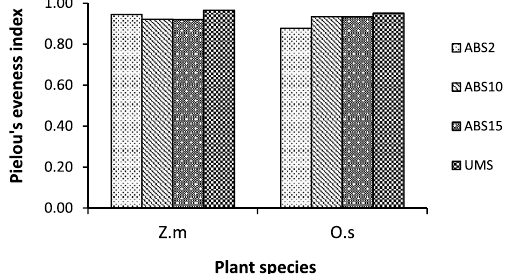
Fig. 5. Pielou’s evenness index of AMF in trap culture set up with study sites derived inocula where Zea mays L. (Z.m) and Oryza sativa L. (O.s) are used as trap plants. Note: ABS2 = 2 years abandoned site, ABS10 = 10 years abandoned site, ABS15 = 15years abandoned site, UMS = un-mined